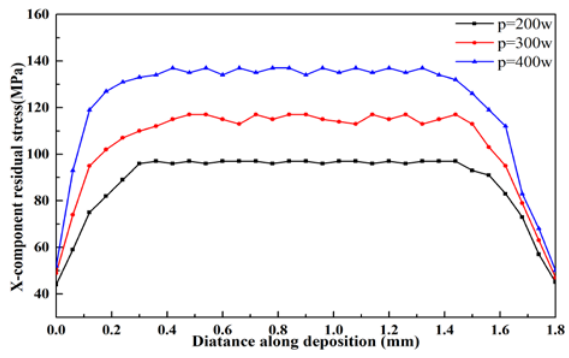
Fig. 4. Residual stress of sample with different laser power